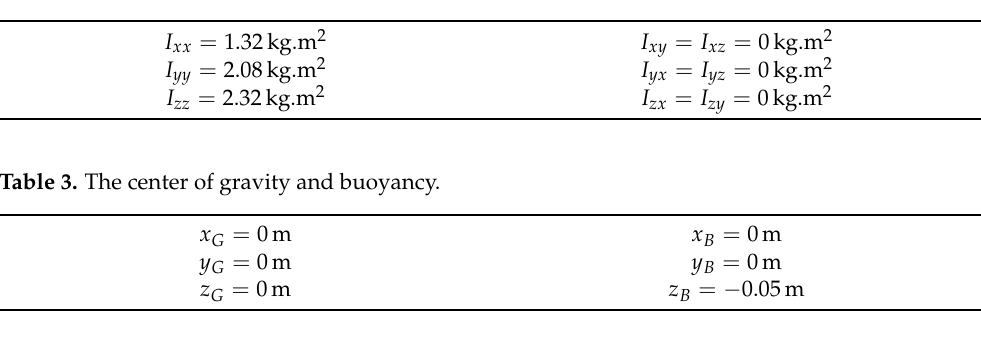
Table 2. The moments of inertia.